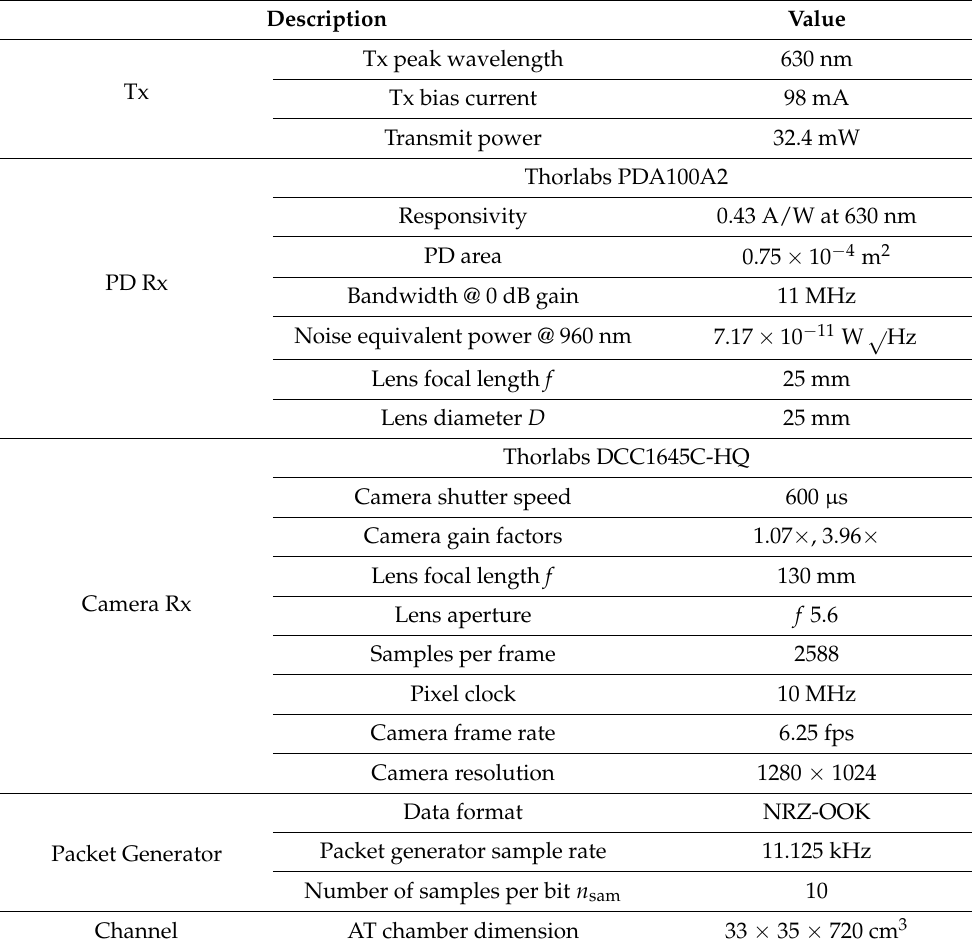
Table 2. Key parameters of the